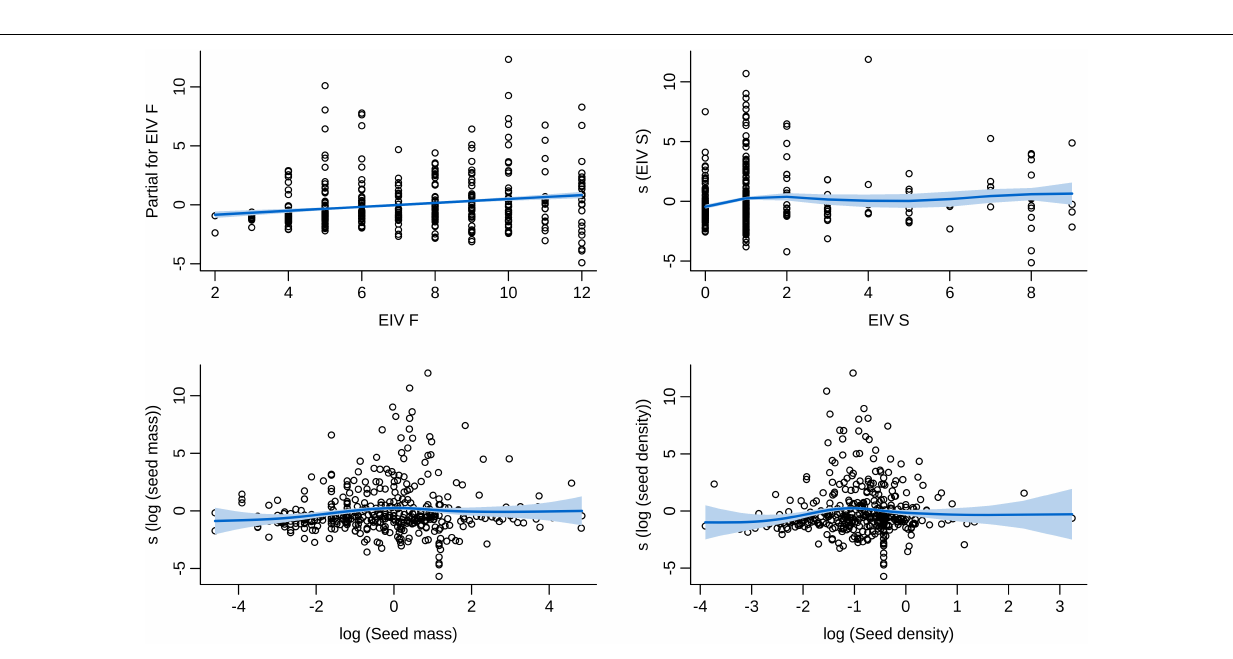
Frontiers in Plant Science |